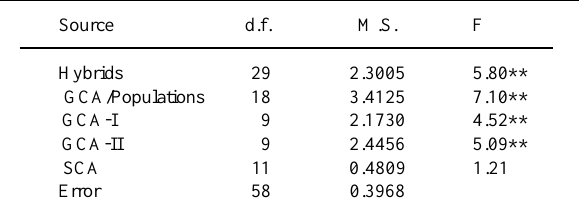
Table VII - Analysis of variance according to the partial circulant diallel model.